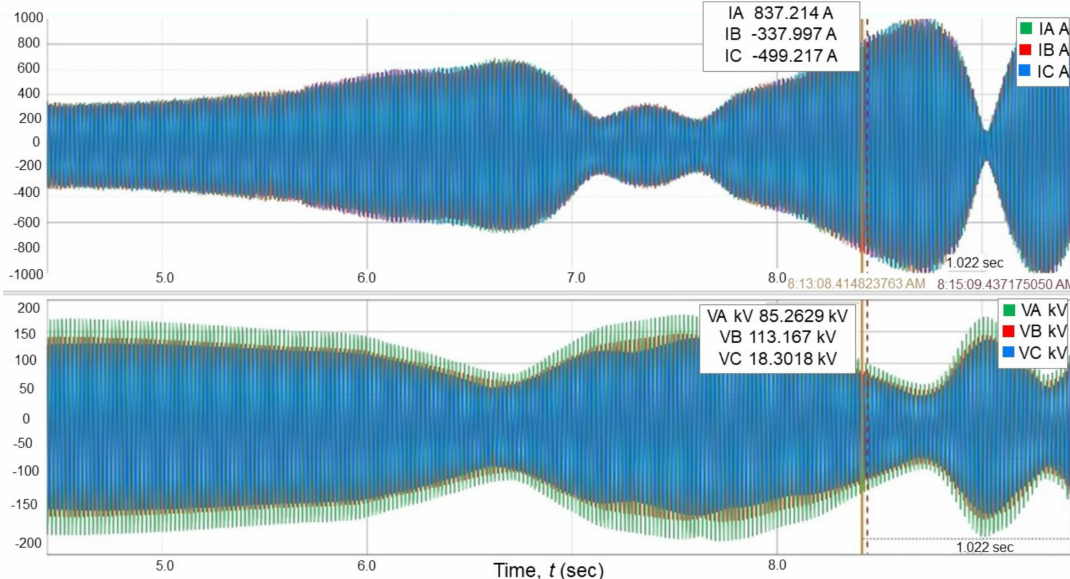
Figure 30. Results of the Cyber-physical tests: OOS proposed